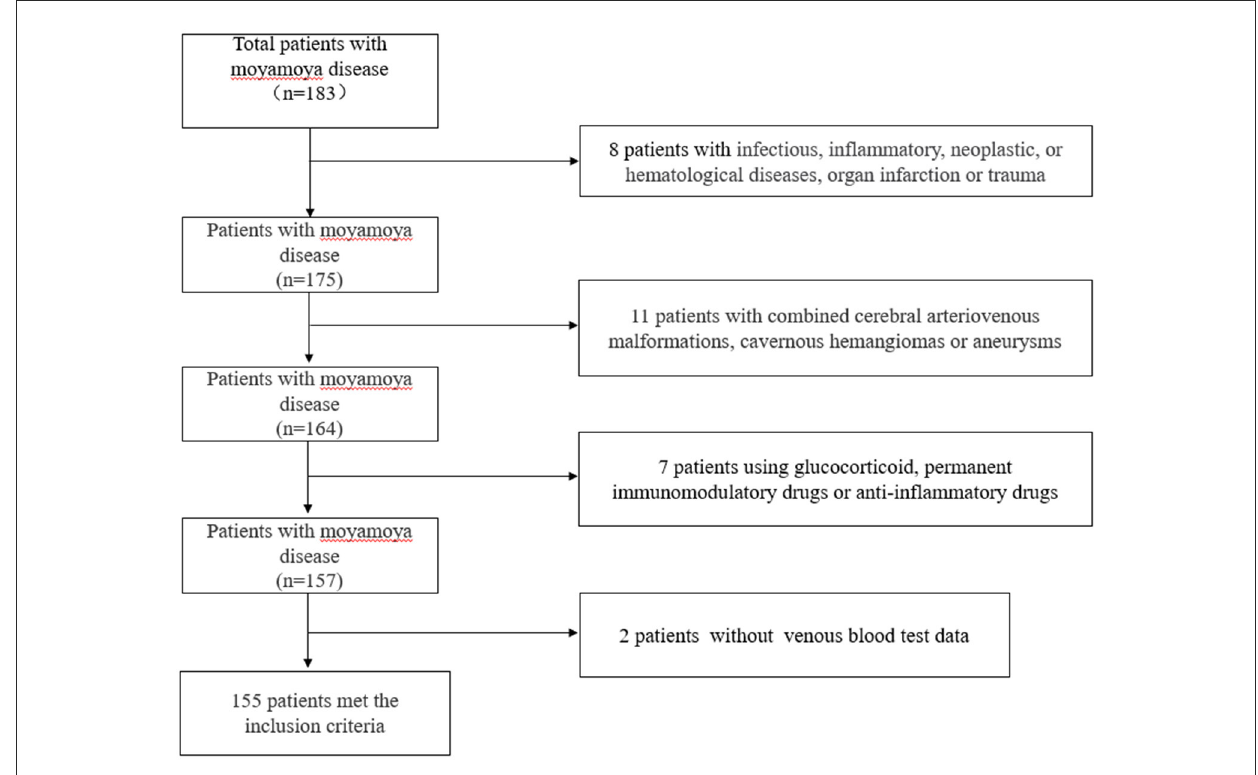
FIGURE1 Patient inclusion flow chart.